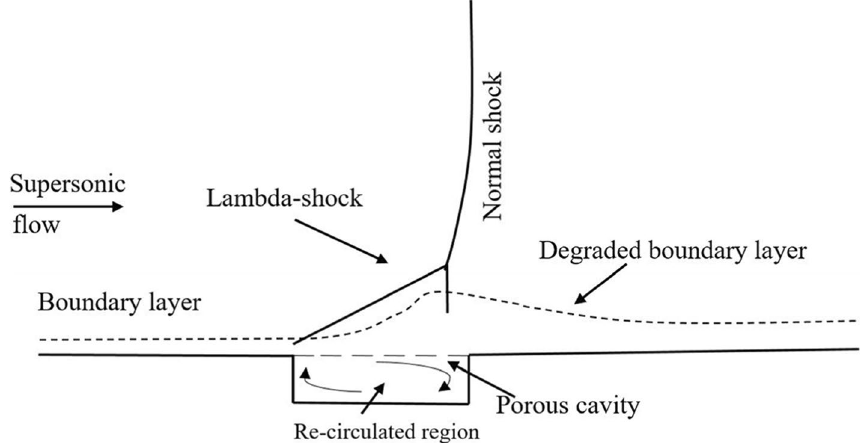
Fig. 7 Control of SBLI using porous cavity [118]